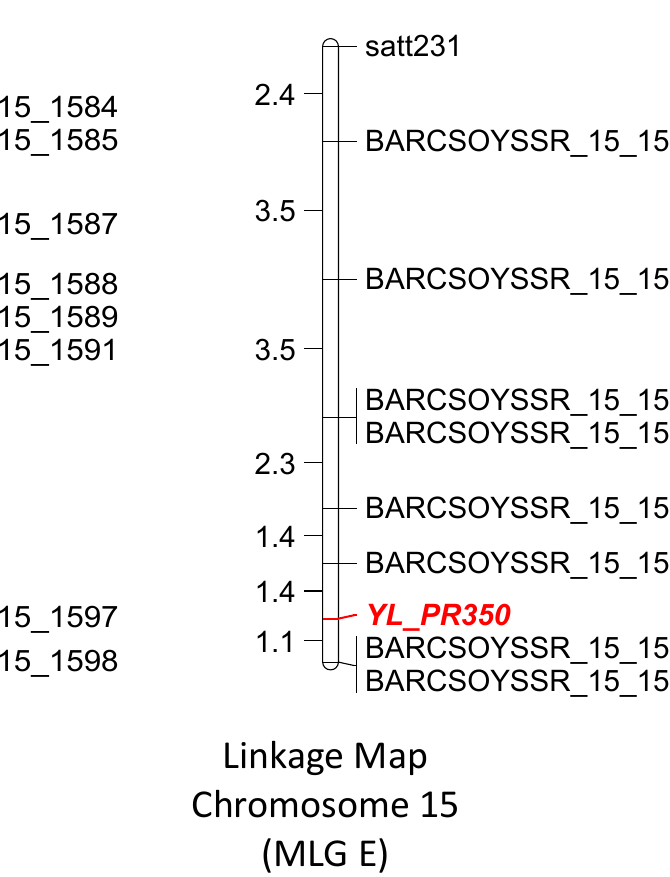
Figure 1. Physical and genetic linkage maps of soybean chromosome Gm15 (MLG E) showing locations of SSR markers close to the yellow-lethal gene YL_PR350 . Physical distances are shown in base pairs (bp) and genetic distances are shown in centiMorgans (cM).